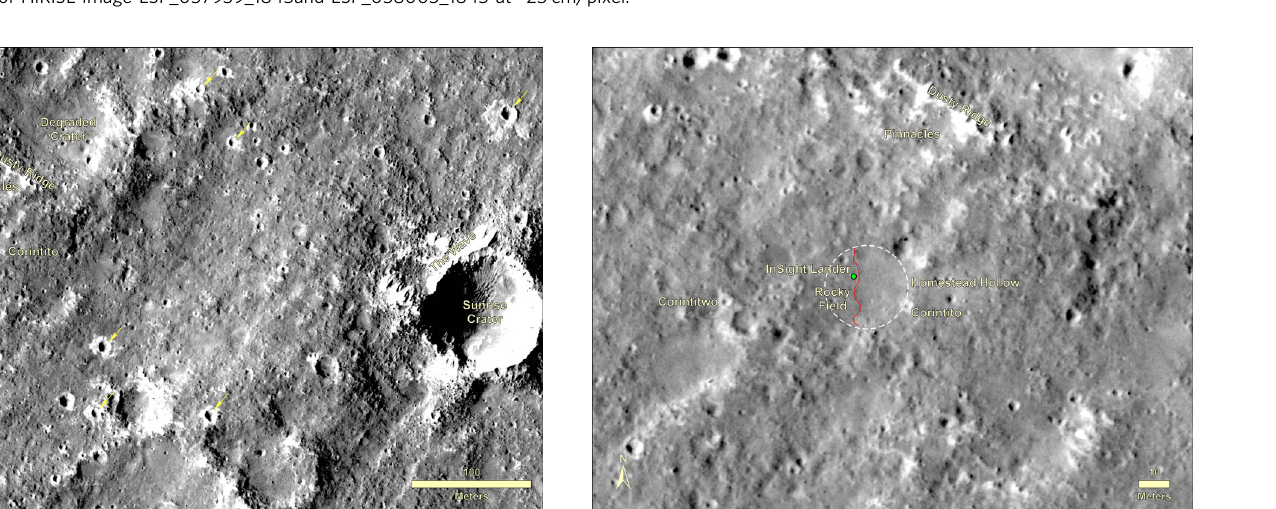
soil is granule- and pebble-rich and otherwise appears similar to the smooth terrain.